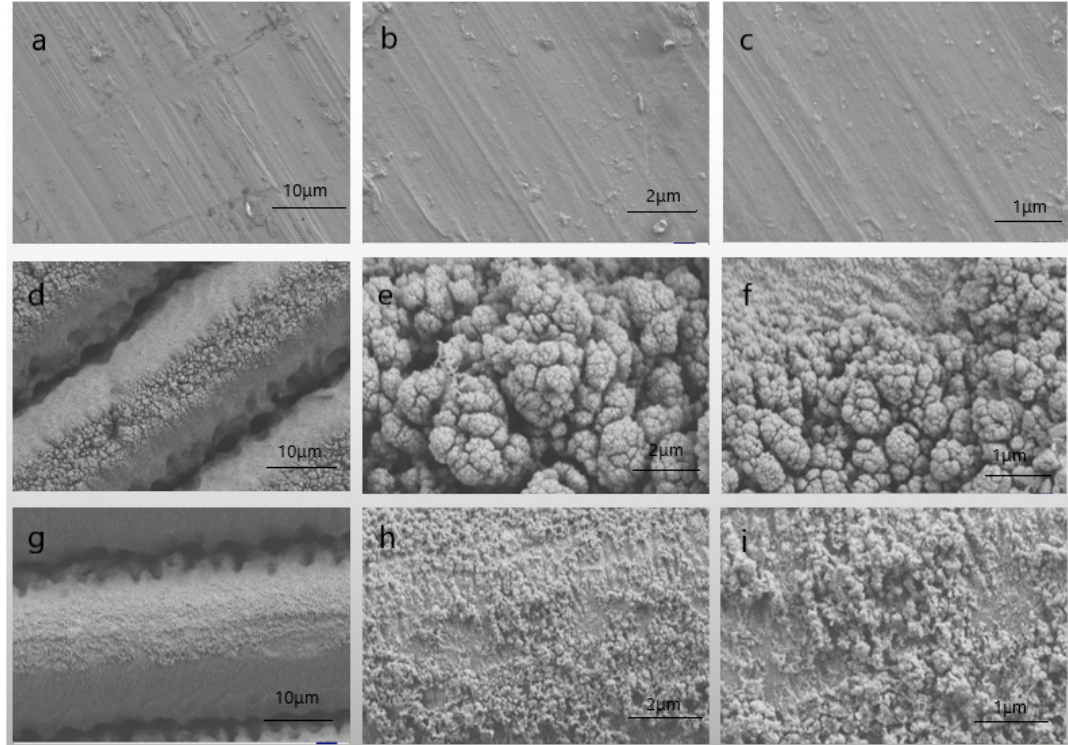
Figure 2. Femtosecond laser preparation of micro- and nanostructures of aluminum-based superhy- drophobic surfaces. ( a – c ) SEM images of the surface of specimen 1#; ( d – f ) SEM images of the surface of specimen 2#; ( g – i ) SEM images of the surface of specimen